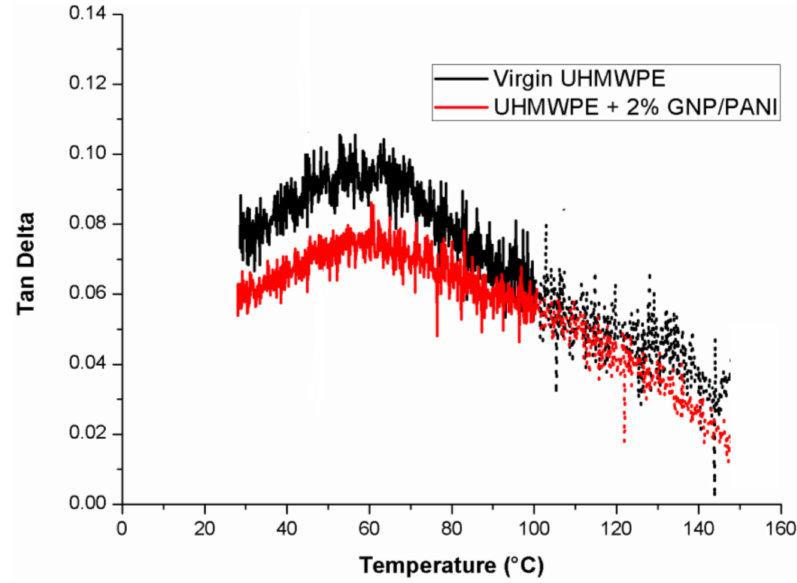
Figure 10. DMA tan δ for the UHMWPE/GNP/PANI